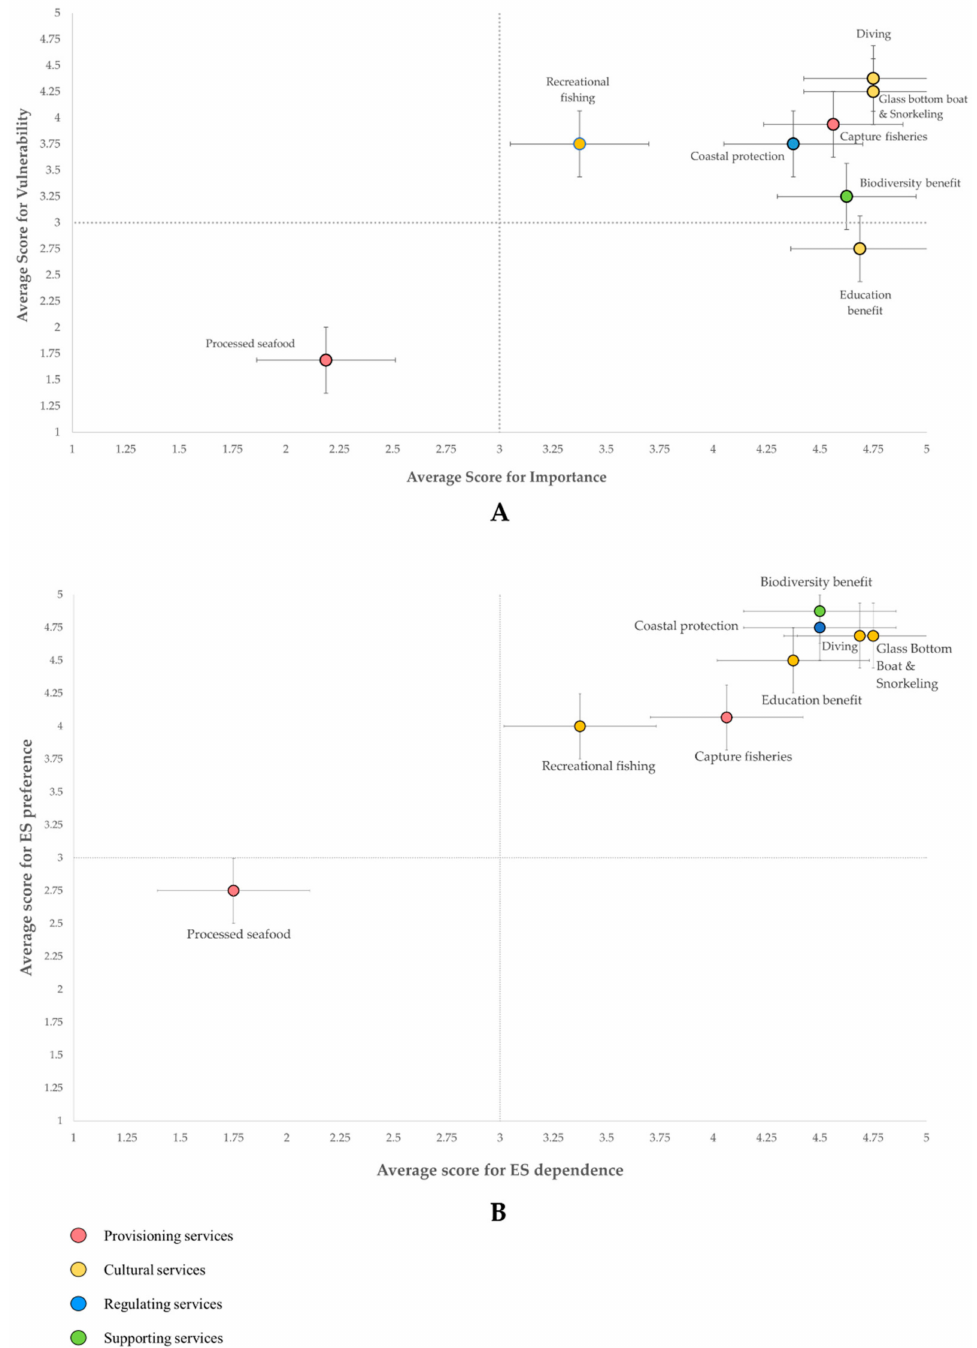
Figure 4. Four quadrant matrixes depicting stakeholder’s valuation for ( A ) Ecosystem Services criticality, and ( B ) Ecosystem Services priority; in the coral reef ecosystem of the GMMTP. The regulating service of coral reefs as coastal protector and shoreline stabiliser scored high in both criticality and priority (Figure 4A,B). The erosion threat in GMMTP has put the service into the community’s focus. Sand erosion has caused loss of some tourist amenities, such as sunbathing spots and snorkelling sites [41]. Erosion has also caused overwash and inundation, which may affect property areas and public roads, as evident in many instances [8]. In one case, it even affected a temporary waste shelter, which disrupted the waste processing chain within the